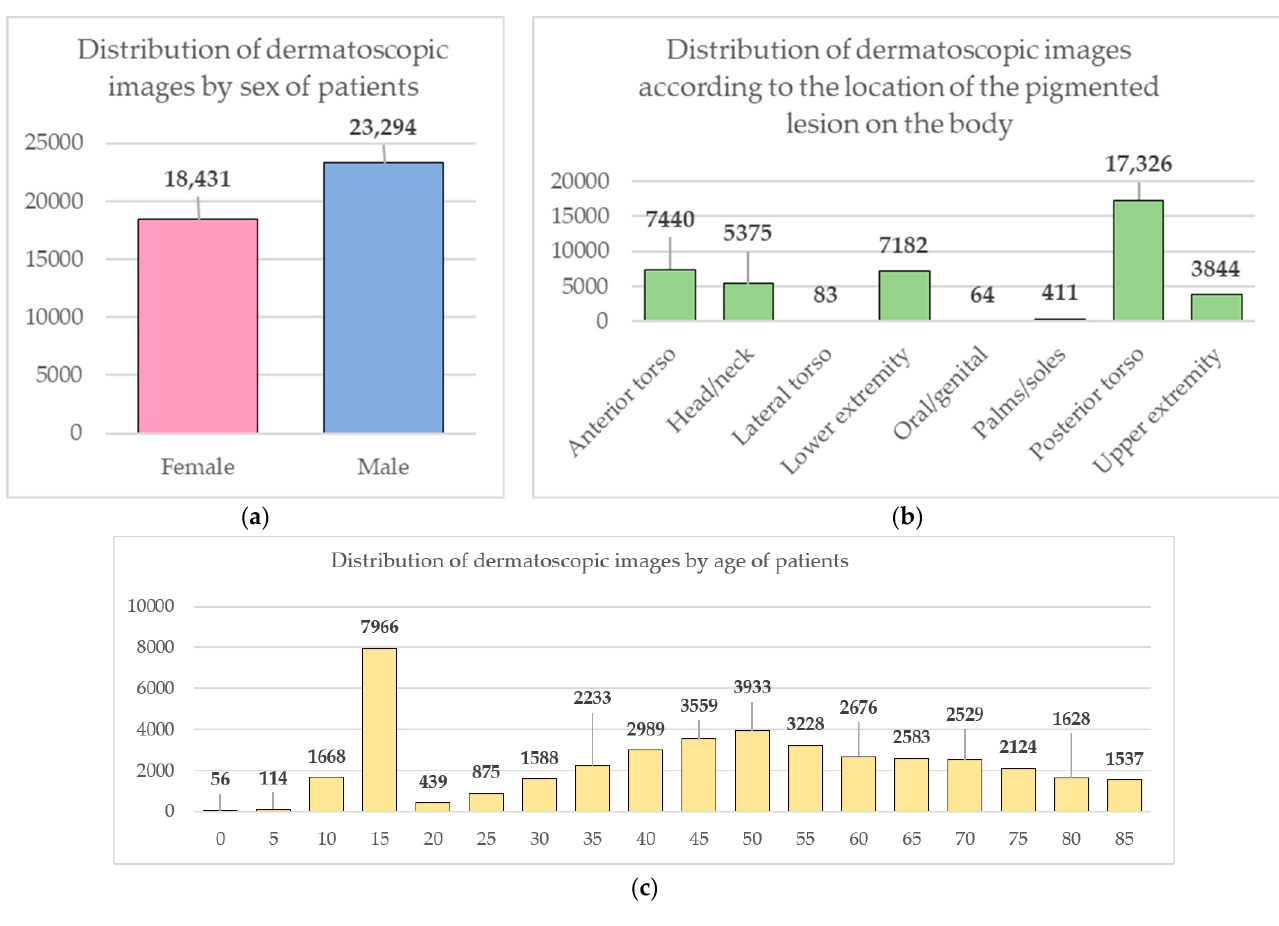
Figure 8. Diagrams of the distribution of the base of dermatoscopic images according to the statis ‐ tical data of patients: ( a ) by gender; ( b ) by age; ( c ) by the location of the pigmented lesion on the body.